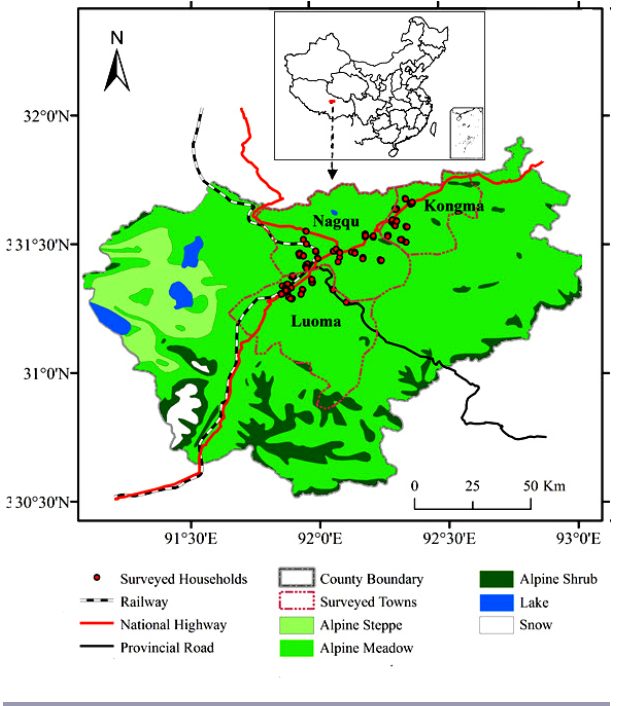
Fig. 3 . The study area and the surveyed households in Nagqu County, Northern